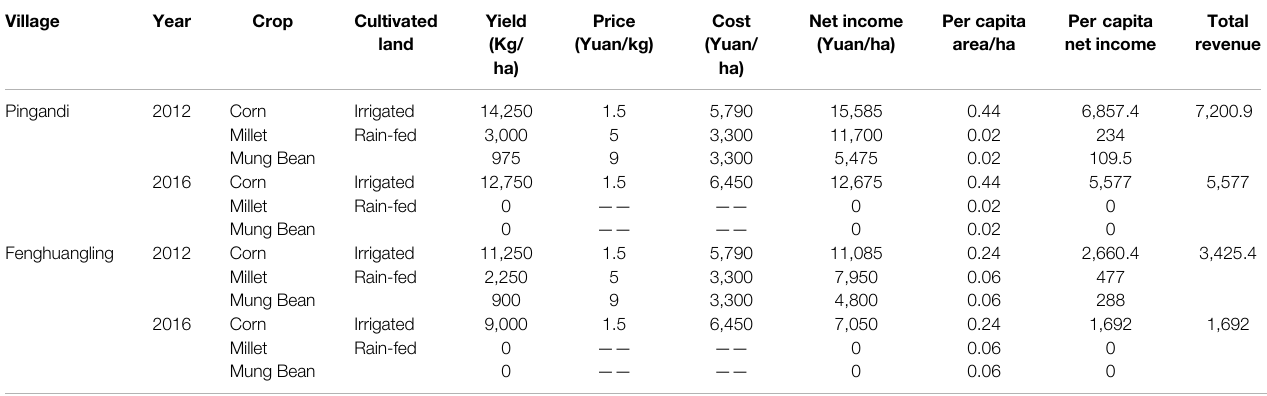
TABLE 4 | Input – output fl ows of farming in farmer villages. Village